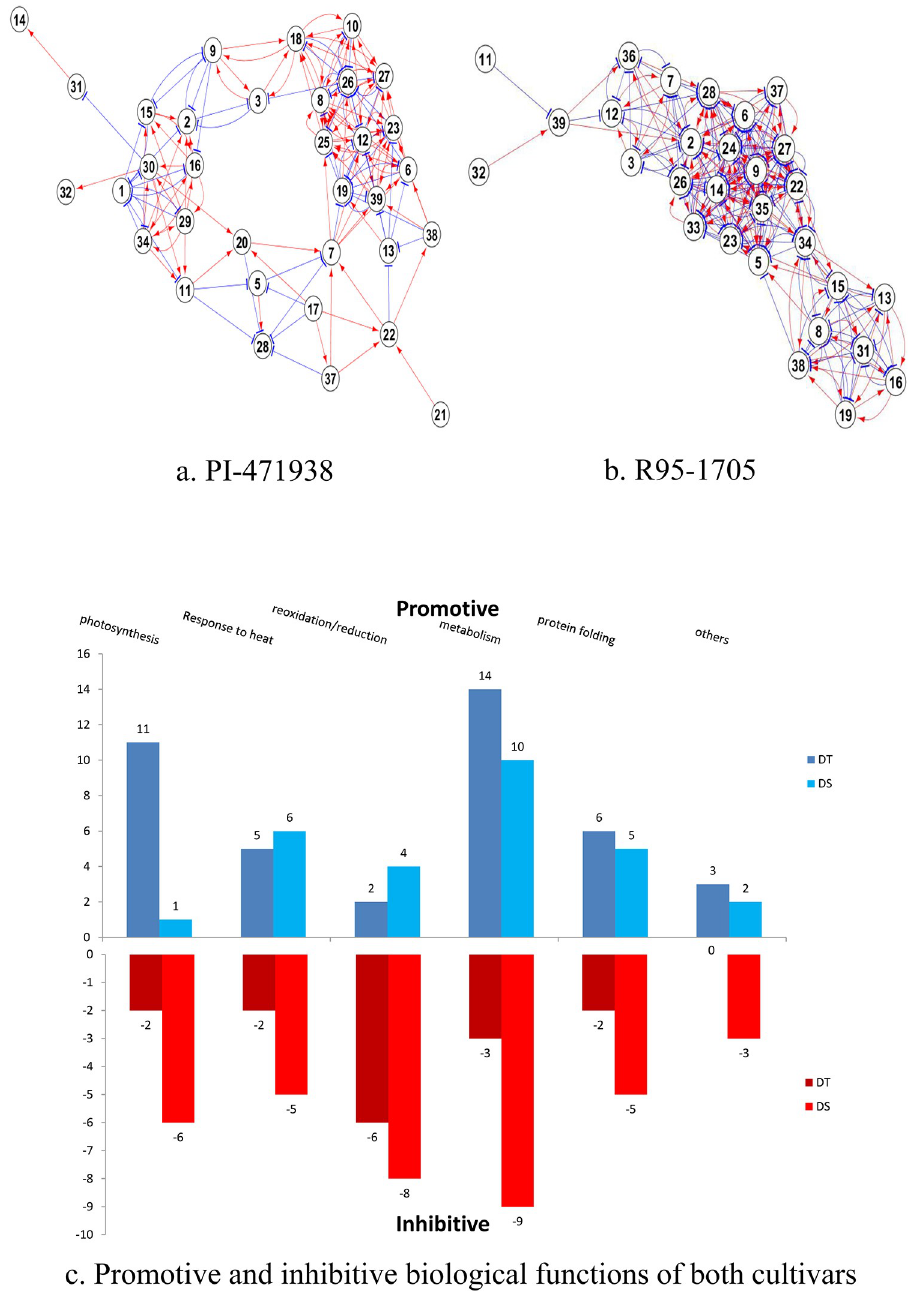
Fig 7. Protein-protein interactions among Stress Responsive Proteins (SRPs) in PI-471938 and R95-1705 cultivars in response to combined water and heat stresses. Protein interactions in a) PI-471938 and b) R95-1705 cultivars. The number of interacting proteins involved in various biological functions is shown in c. The estimated interactions were evaluated based on a goodness-of-fit calculated from “multiple-correlation coefficient” (R 2 ) between an expression profile and simulated profile of a protein positioned on the downstream side of an interaction. The interactions showing an r2 value (coefficient of determination) > 0.9 were considered as candidate interactions. We calculated the R 2 corresponding to the interaction that a protein regulated the expression of another protein based on a modified version of the S-system differential equation. Spot numbers are the same as in Table 2.